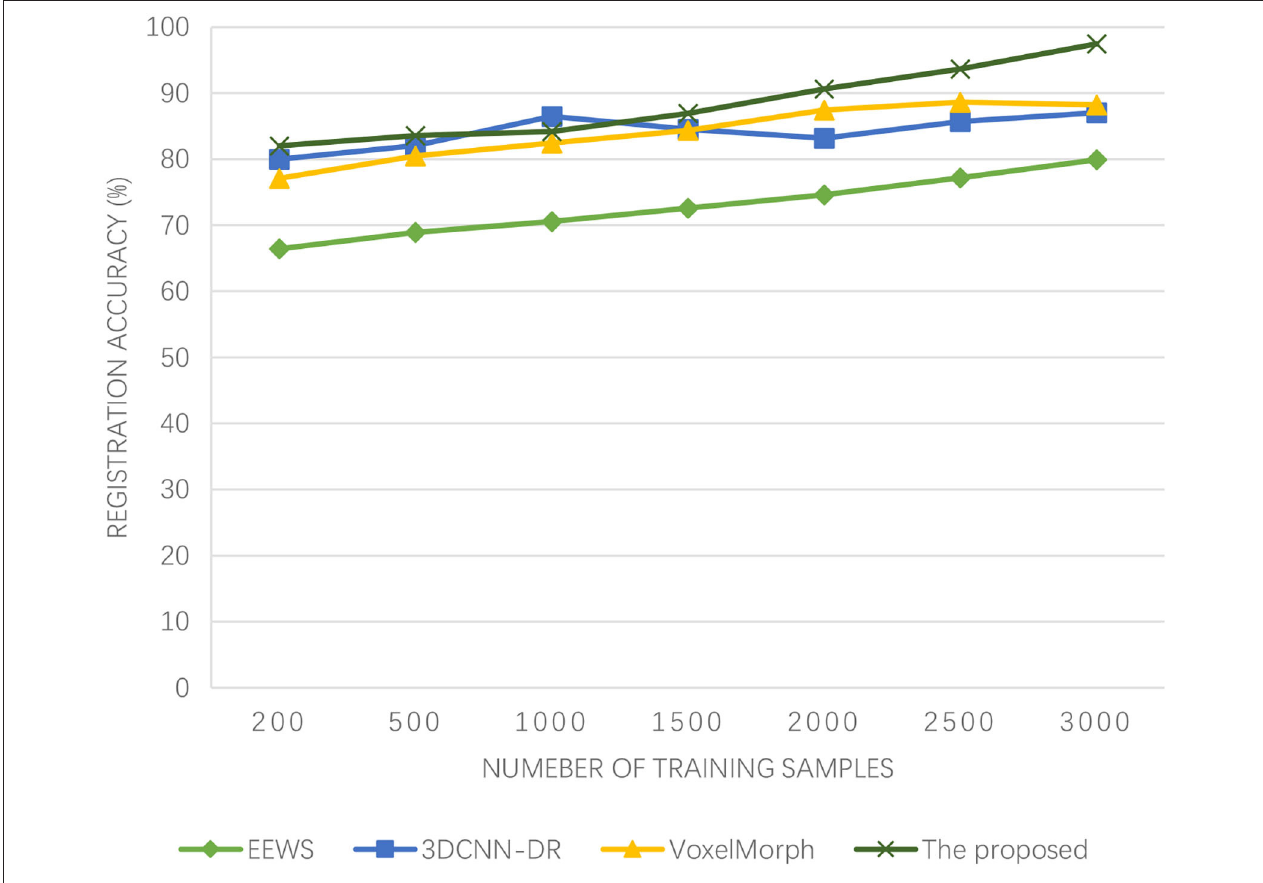
FIGURE 5 | Experimental results of registration